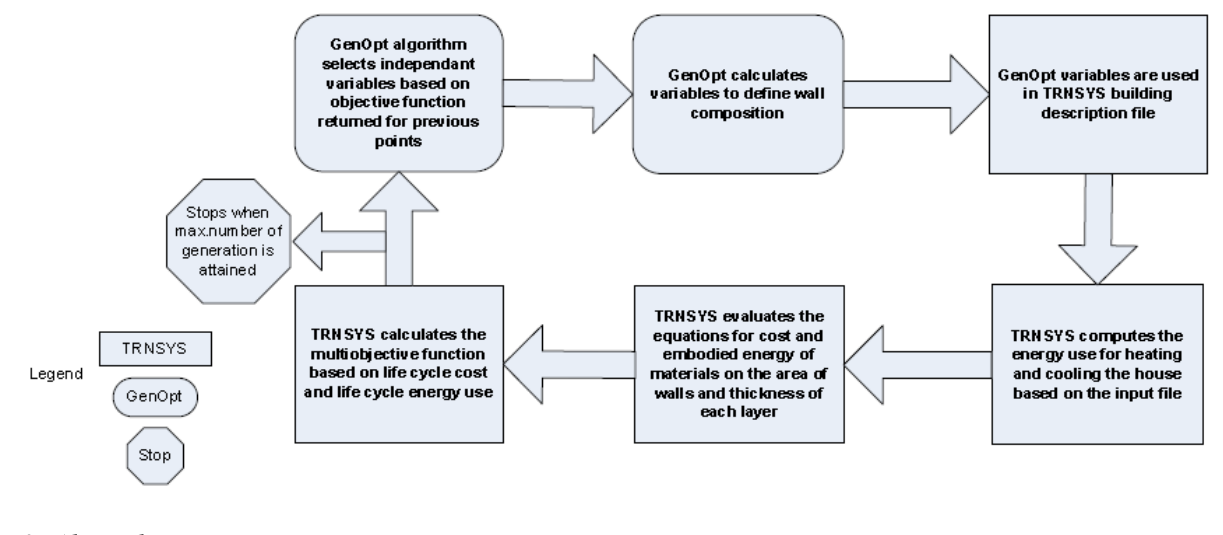
Figure 4. Flowchart of coupling between TRNSYS and